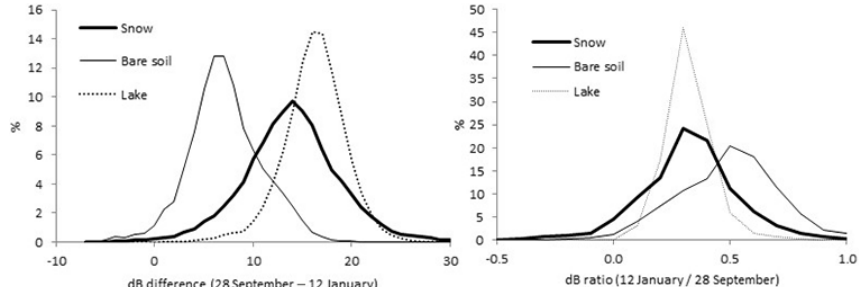
Figure 14. Discrimination of wet snow, bare soil and water using simple band maths: (a) difference between the dry-snow scene (28 Septem- ber 2012, HH Pol) and target scene (12 January 2012), (b) band ratio between the dry-snow scene and the target scene.